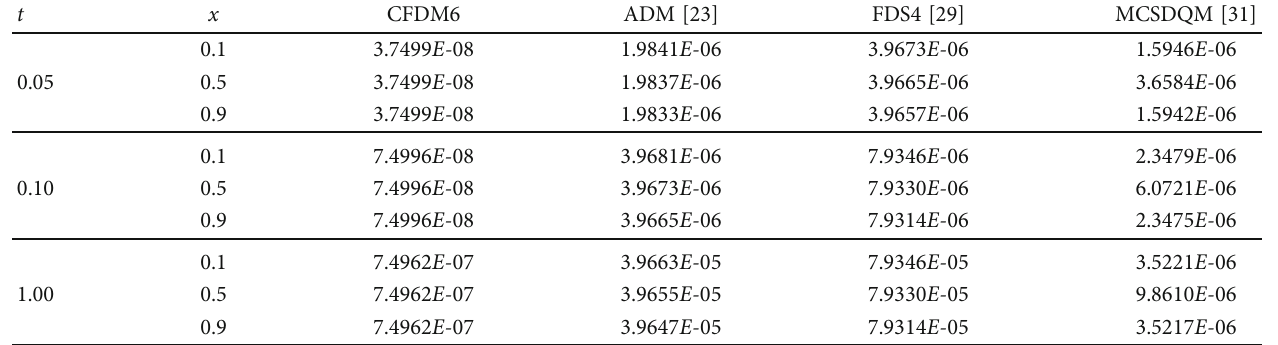
Table 12: Comparison of absolute error of Example 7 with β = 0 , γ = 1 , η = 0 : 001 , δ = 3 , h = 0 : 1 , and Δ t = 0 : 0001 :